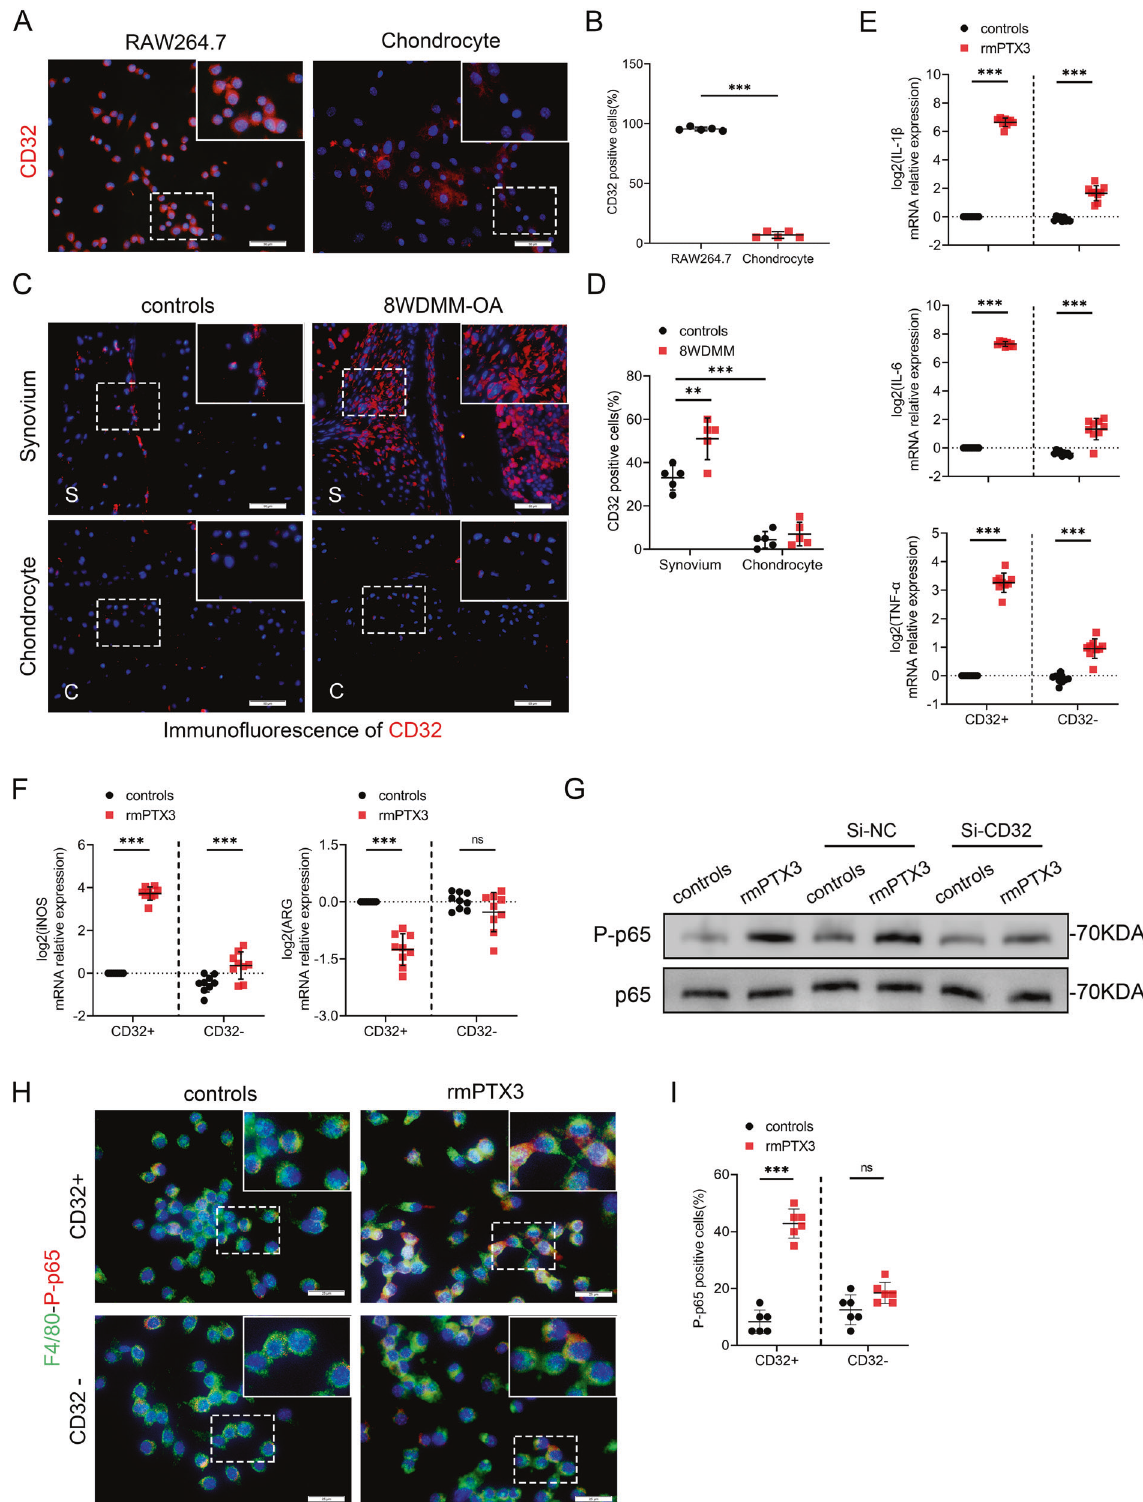
Fig. 5 PTX3 promotes OA by interaction with macrophage CD32. A , B Immuno fl uorescent staining and quanti fi cation of CD32 for RAW264.7 and chondrocytes, n = 5 per group. Scale bar: 50 µm. C , D Immuno fl uorescent staining and quanti fi cation of CD32 of synovial tissues (upper) and knee cartilage (lower) from controls and 8 week-DMM-OA mice, n = 5 per group. Scale bar: 50 µm. E Relative mRNA expression levels of IL- 1 β , IL-6 and TNF- α in Si-CD32- or rmPTX3-treated RAW264.7 cells, n = 9 per group. F Relative mRNA expression levels of iNOS and ARG in Si- CD32- or rmPTX3-treated RAW264.7 cells, n = 9 per group. G Immunoblotting of P-p65 and p65 of RAW264.7 cells treated with Si-CD32 or rmPTX3. H , I IF staining and quanti fi cation of F4/80 and P-p65 in RAW264.7 treated with Si-CD32 or rmPTX3, n = 6 per group. Scale bar: 25 µm. * P < 0.05, ** P < 0.01, *** P < 0.001, ns not signi fi cant. Data are shown as means ± SD. Statistical analyses were conducted by unpaired t -test ( B ) or two-way analysis of variance followed by Sidak ’ s multiple comparison test ( D , E , F , and I ). Boxed area is enlarged in the top right corner. Cell Death and Disease (2022)